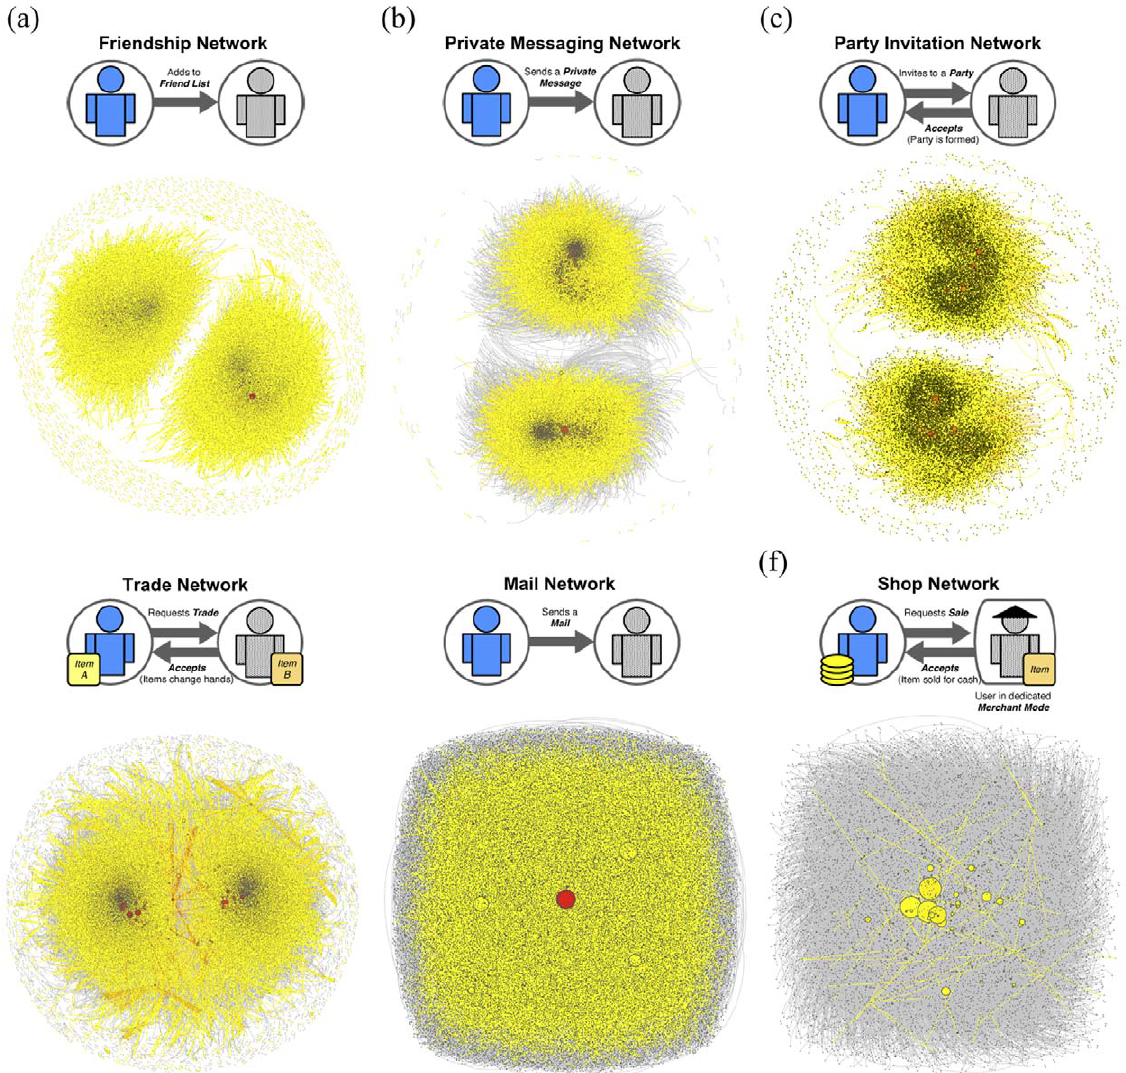
Figure 2. The definition and the graphic representation of the six AION networks. The Realm-vs-Realm design of AION where gamers belong to one of two tribes (Heavenly and Diabolical) that cannot communicate is evident in the existence of two similarly-sized large components. Red-colored nodes indicate exceptionally high-degree nodes.